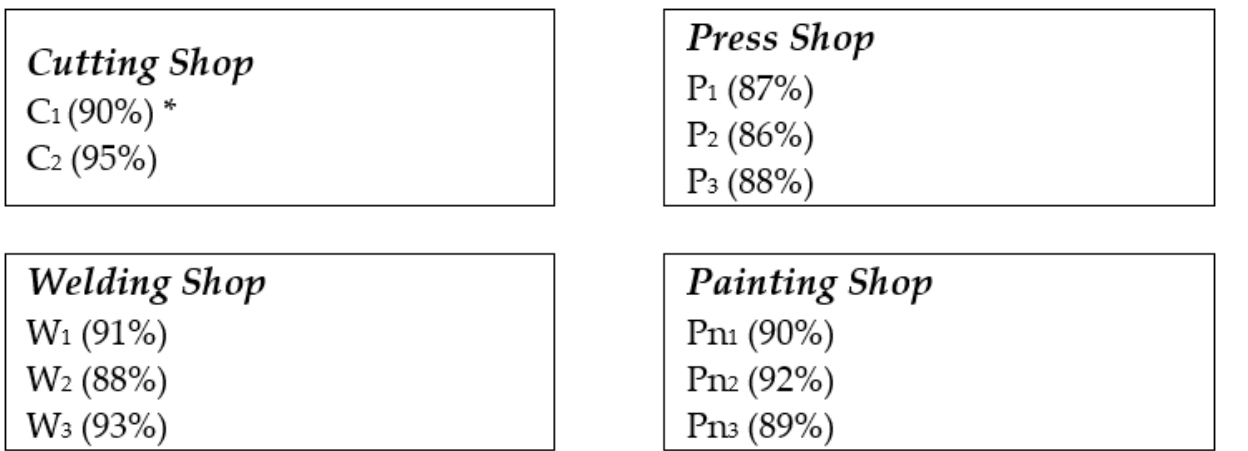
Figure 11. Graphical view of the case study. * The numbers in the parenthesis show the quality ratio of outcomes by using a machine.